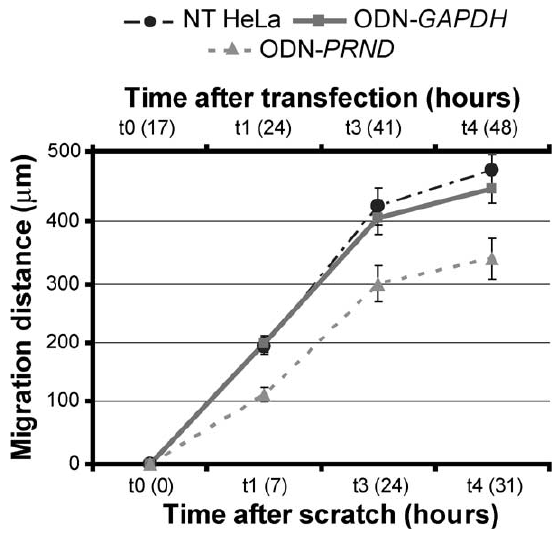
Fig. 3. Migration rate rescue in Dpl-expressing HeLa cells. The PRND -specific S-ODN treatment of the stably Dpl-expressing HeLa cells reduced their migration capability respects to un- treated (NT HeLa) and to GAPDH -specific S-ODN treated cells (ODN- GAPDH ). Statistical analysis was performed by Student’s t test ( p < 0 .